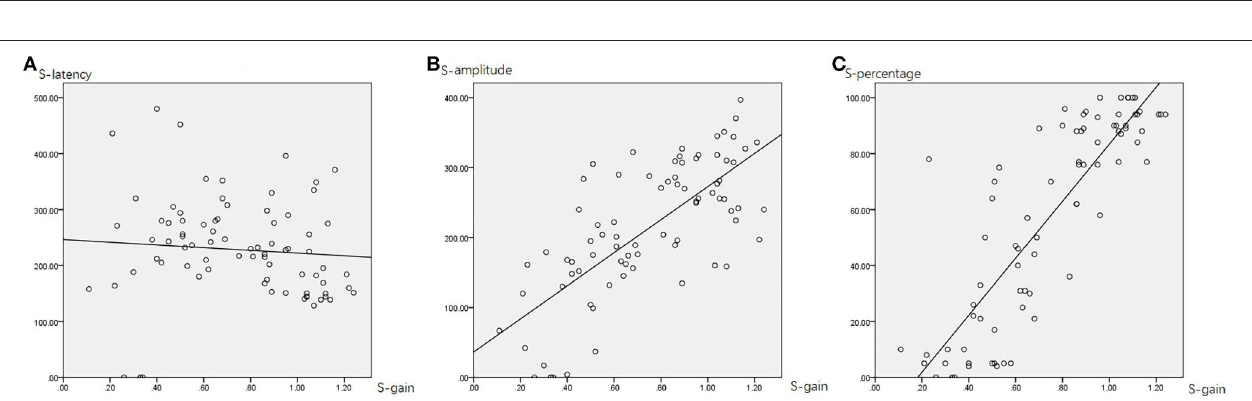
FIGURE 6 | The correlation between HIMP gain and saccade latency (A) , amplitude (B) , and percentage (C) . The gain and latency were weakly negatively correlated. However, the saccade amplitude and percentage had strong and moderate negative correlations, respectively, with gain.